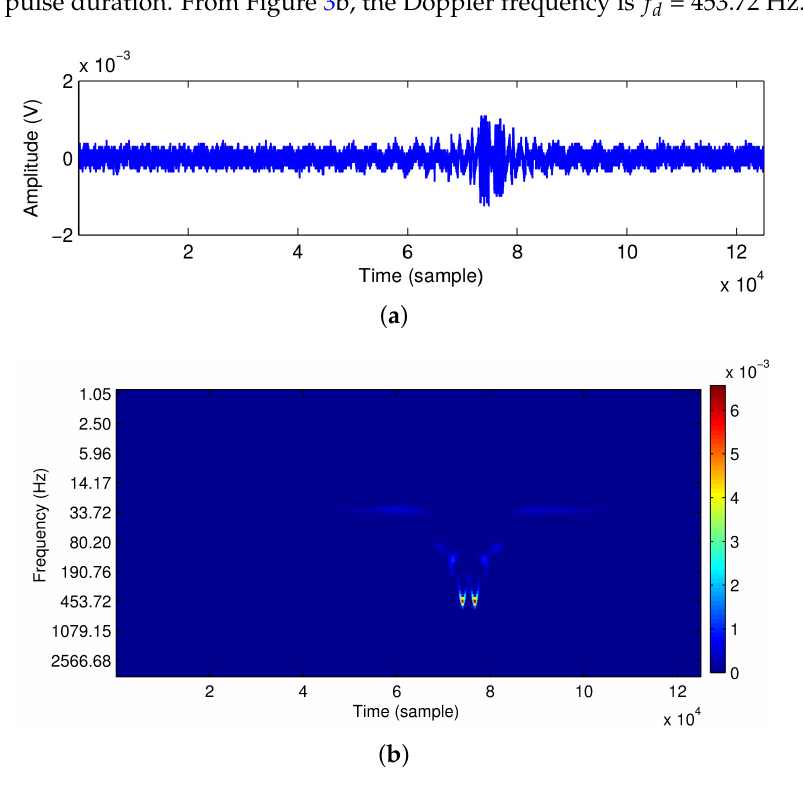
Figure 3. Time-Frequency representation of the OFI signal. ( a ) OFI signal; ( b ) scalogram of the OFI